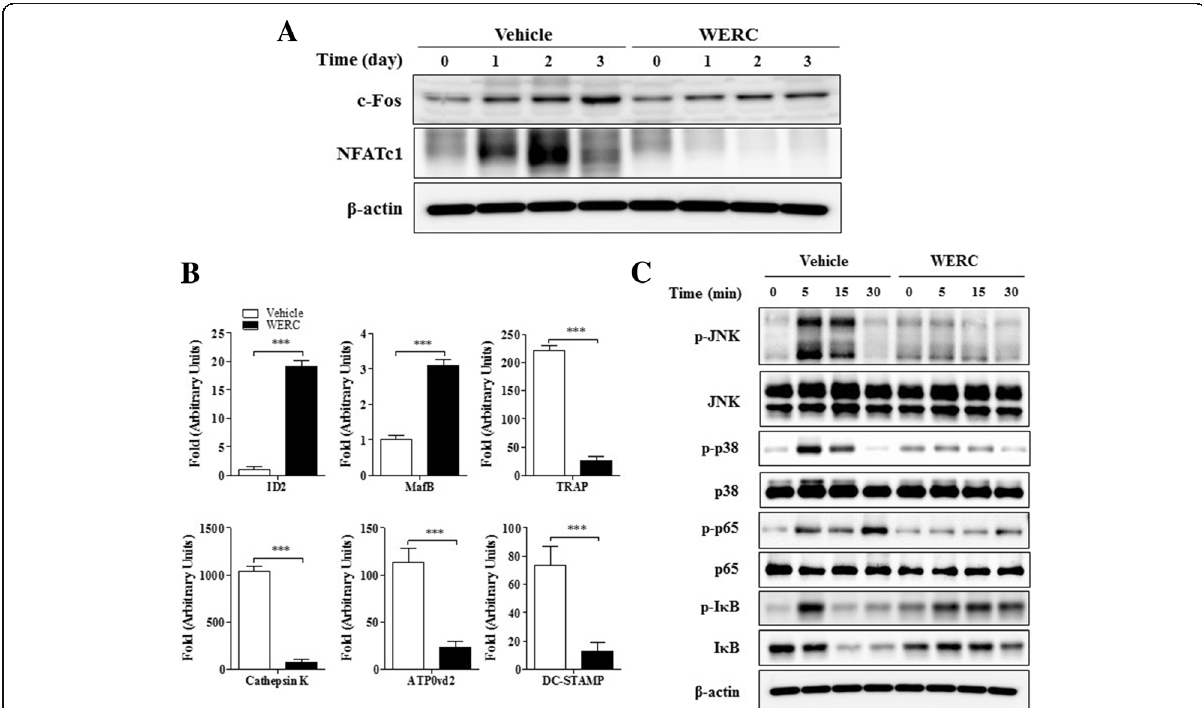
Fig. 5 WERC inhibits c-Fos and NFATc1 expression in osteoclasts. BMMs were incubated with vehicle or WERC (80 μ g/mL) for 4 days in the presence of M-CSF and RANKL. ( a ) Total cell lysate collected for each time point was subjected to western blot analysis with c-Fos or NFATc1 antibody. ( b ) mRNA levels of Id2, MafB, TRAP, cathepsin K, ATPv0d2, and DC-STAMP were analyzed by qRT-PCR on day 3. ( c ) BMMs pre-treated with vehicle or WERC (80 μ g/mL) in the presence of M-CSF for 3 h were incubated with RANKL (100 ng/mL) for 0, 5, 15, and 30 min. Total cell lysate (30 μ g) was subjected to western blot analysis with antibodies specific to JNK, p38, p65, and I- κ B. *** p < 0.001 vs.